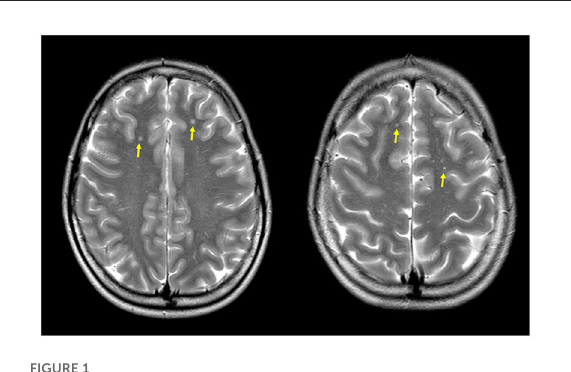
FIGURE1 Magnetic resonance (MR) axial T2-weighted-FLAIR images showing multiple focal bilateral supratentorial white matter hyperintensities (yellow arrows).